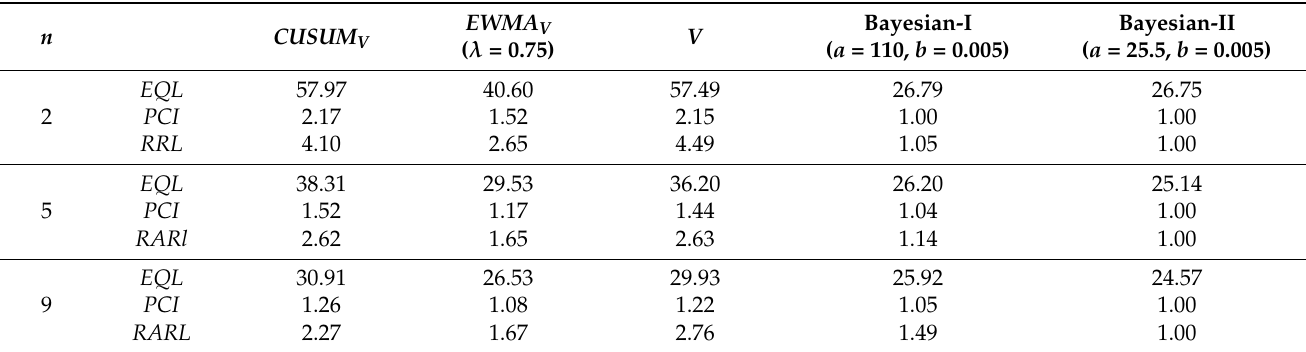
Table 6. Overall performance comparison of the Bayesian-I and Bayesian-II Shewhart-type control charts versus the CUSUM V and V control